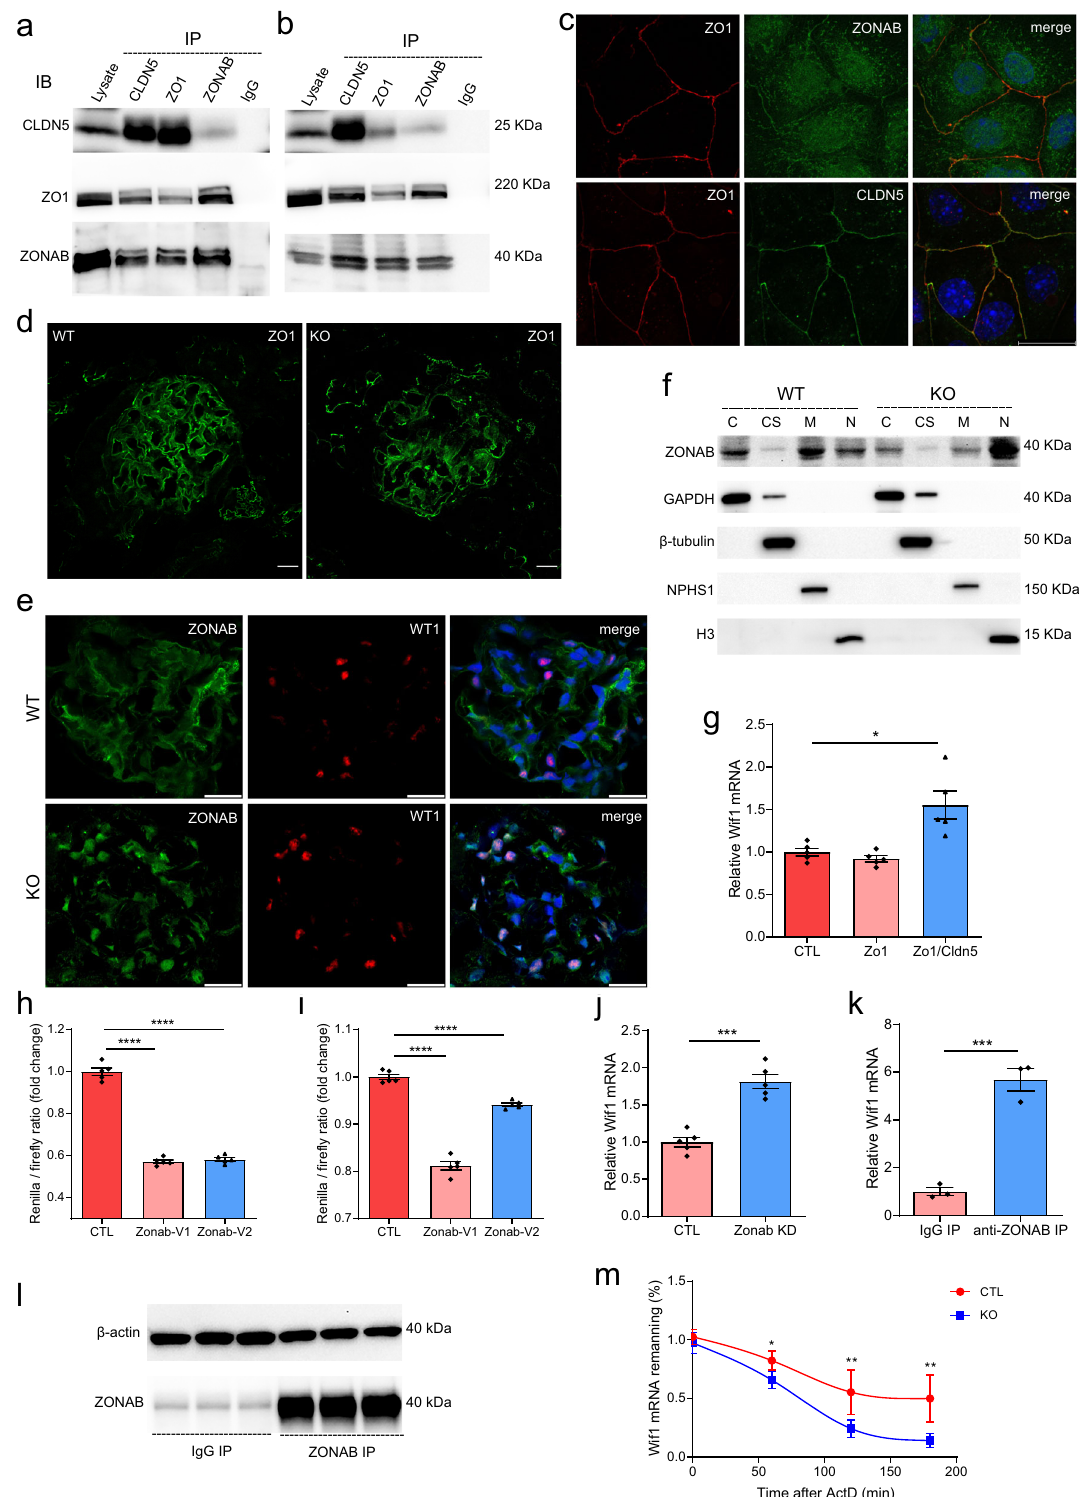
Statistics and reproducibility . The signi fi cance of differences between groups was tested by Prism 6.07 (GraphPad Software Inc.). Statistical analysis was performed using two-tailed unpaired Student ’ s t test determine differences between two groups. P -values <0.05 were interpreted as statistically signi fi cant. All data are presented as mean±SEM and other details such as the number of replicates and the level of signi fi cance are mentioned in fi gure legends and Supplementary